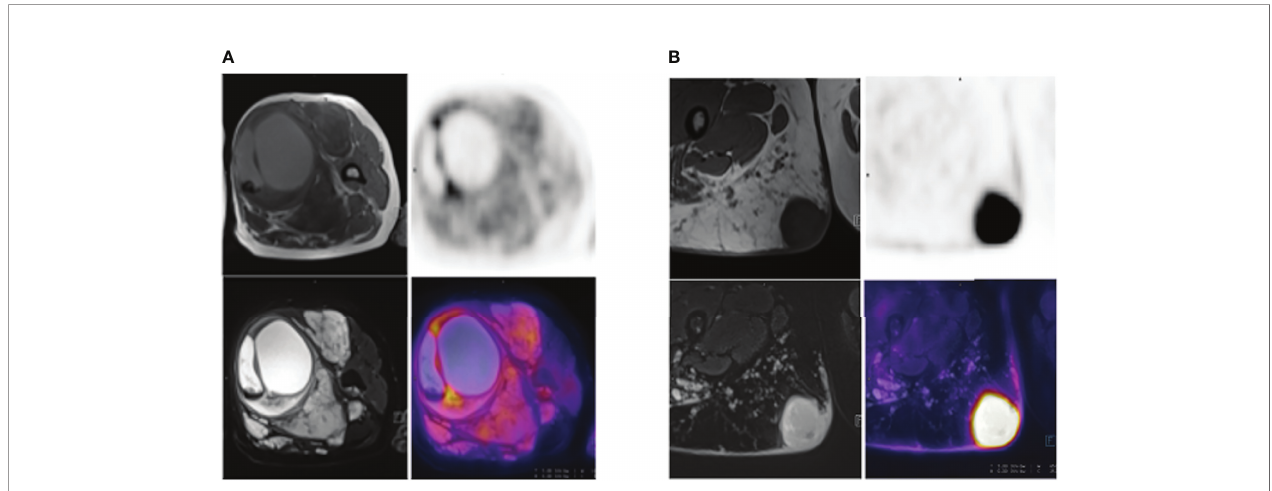
FIGURE 4 | (A) A 52-year-old NF1 patient with benign PNF lesions, particularly in the left thigh. The lesion was located in the soft tissue of the upper segment of the left thigh, was approximately 8.7 cm-9.5 cm in size, with clear boundary, heterogeneous internal signal, visible cystic degeneration with hemorrhage, and increased FDG uptake at the septa, SUVmax=4.9. (B) A 28-year-old NF1 patient with a MPNST in the upper segment of the right thigh, measuring 3.9 cm – 3.8 cm, with well- de fi ned borders and increased FDG uptake,